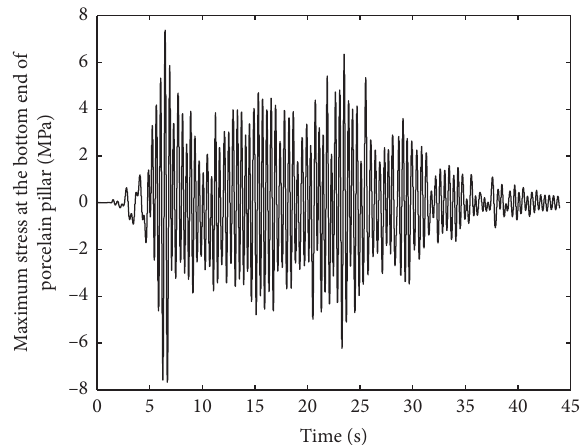
Figure 18: Displacement at the top of porcelain pillar ( a � 0.5g, η � 0).